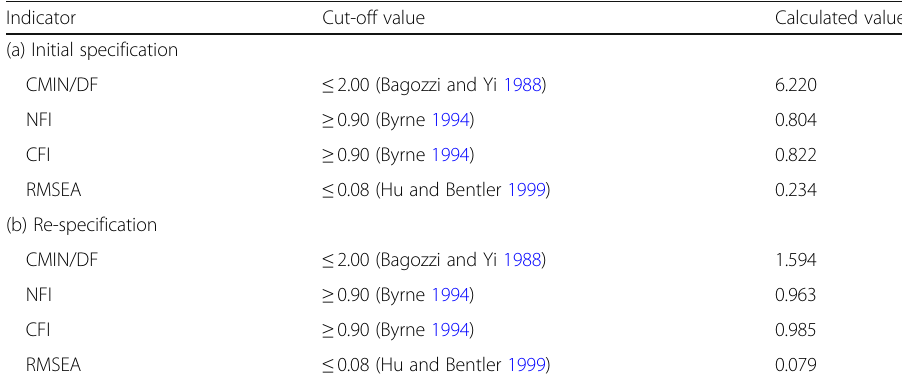
Table 7 H2 SEM model fit indicators Indicator Cut-off value Calculated